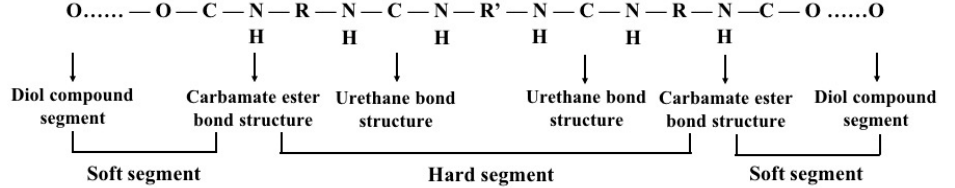
Figure 7. The structure of polyurethane (the urethane groups –NH–(C = O)–O– link the molecular units for polyurethane synthesis).